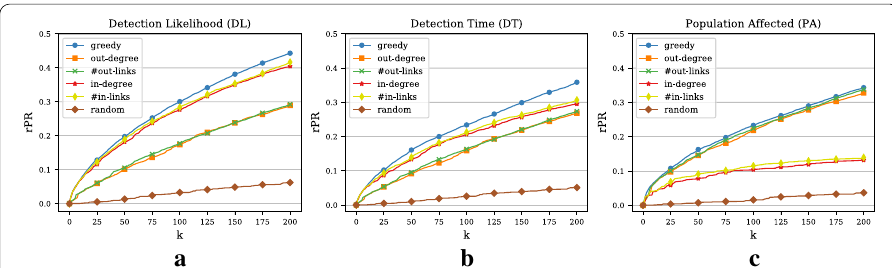
Fig. 7 Relative penalty reductions (rPR) and comparison with benchmarks (Example 2). a Relative penalty reduction for DL objective. The x-axis represents the size of the monitoring set k . We only plot the curves for the top 200 nodes. Since the network is directed, we compare with both the in- and out-degree heuristic as well as the in- and out-links heuristic. b Relative penalty reduction for DT objective. c Relative penalty reduction for PA